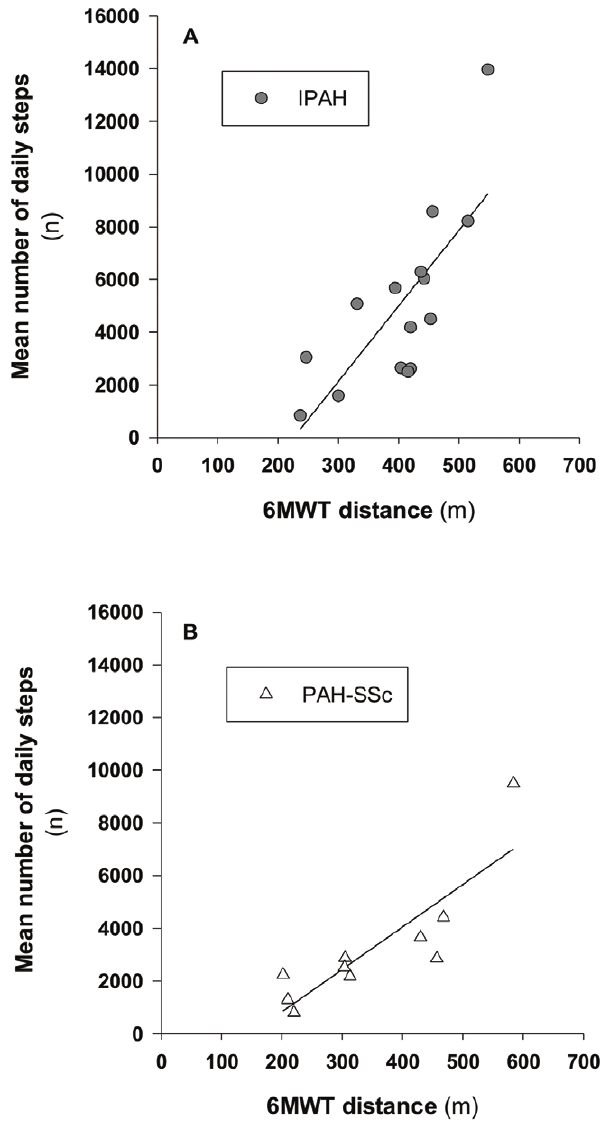
Figure 2. Correlation between exercise capacity and daily steps in pulmonary arterial hypertension patients. Correlation between the six-minute walk test (6MWT) distance and the mean daily steps in patients with idiopathic pulmonary arterial hypertension (IPAH; panel A) and in patients with pulmonary arterial hypertension associated with limited systemic sclerosis (PAH-SSc; panel B). Figure legend: n, number; min, minute.